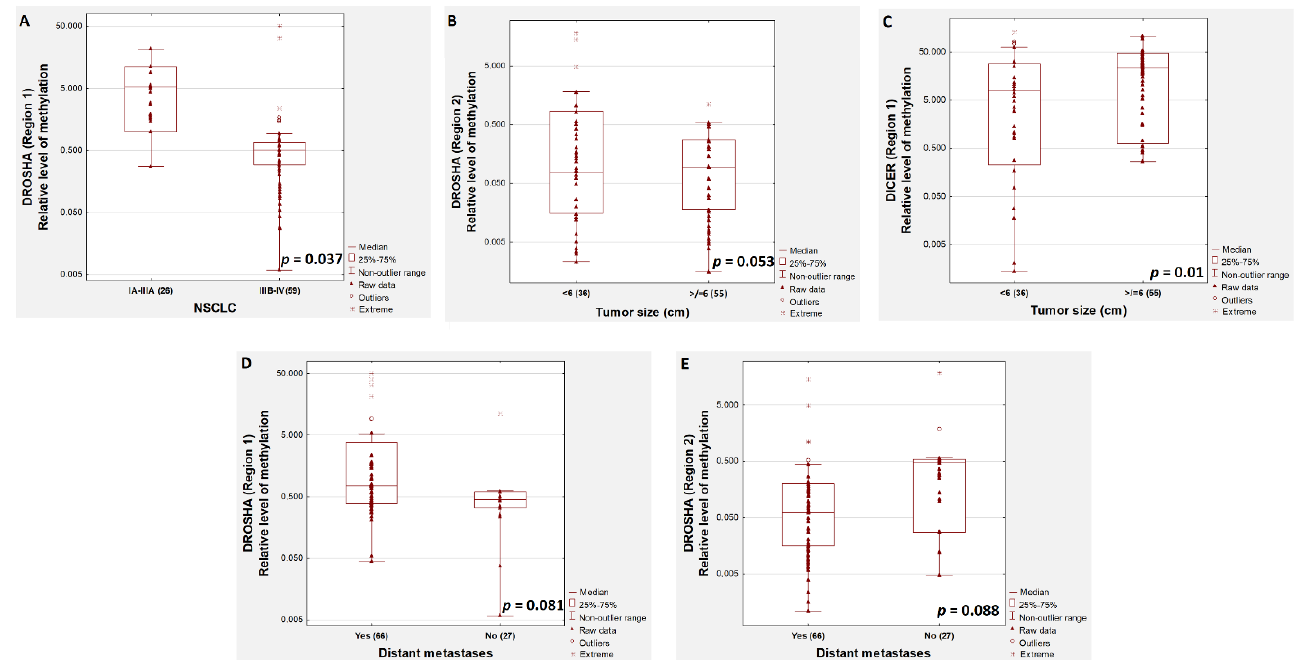
Figure 2. Comparison of the relative methylation level of DROSHA and DICER genes in patients with early and advanced stages of NSCLC ( A ), according to tumour size ( B , C ) and occurrence of distant metastases ( D , E ).